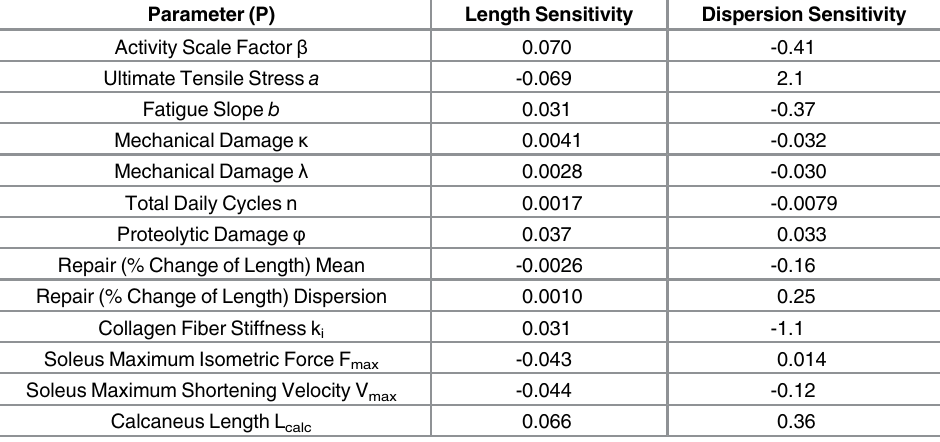
Table 2. Sensitivity to changes of model parameters (% change Y/% change P, where Y is tendon length or dispersion, and P are model